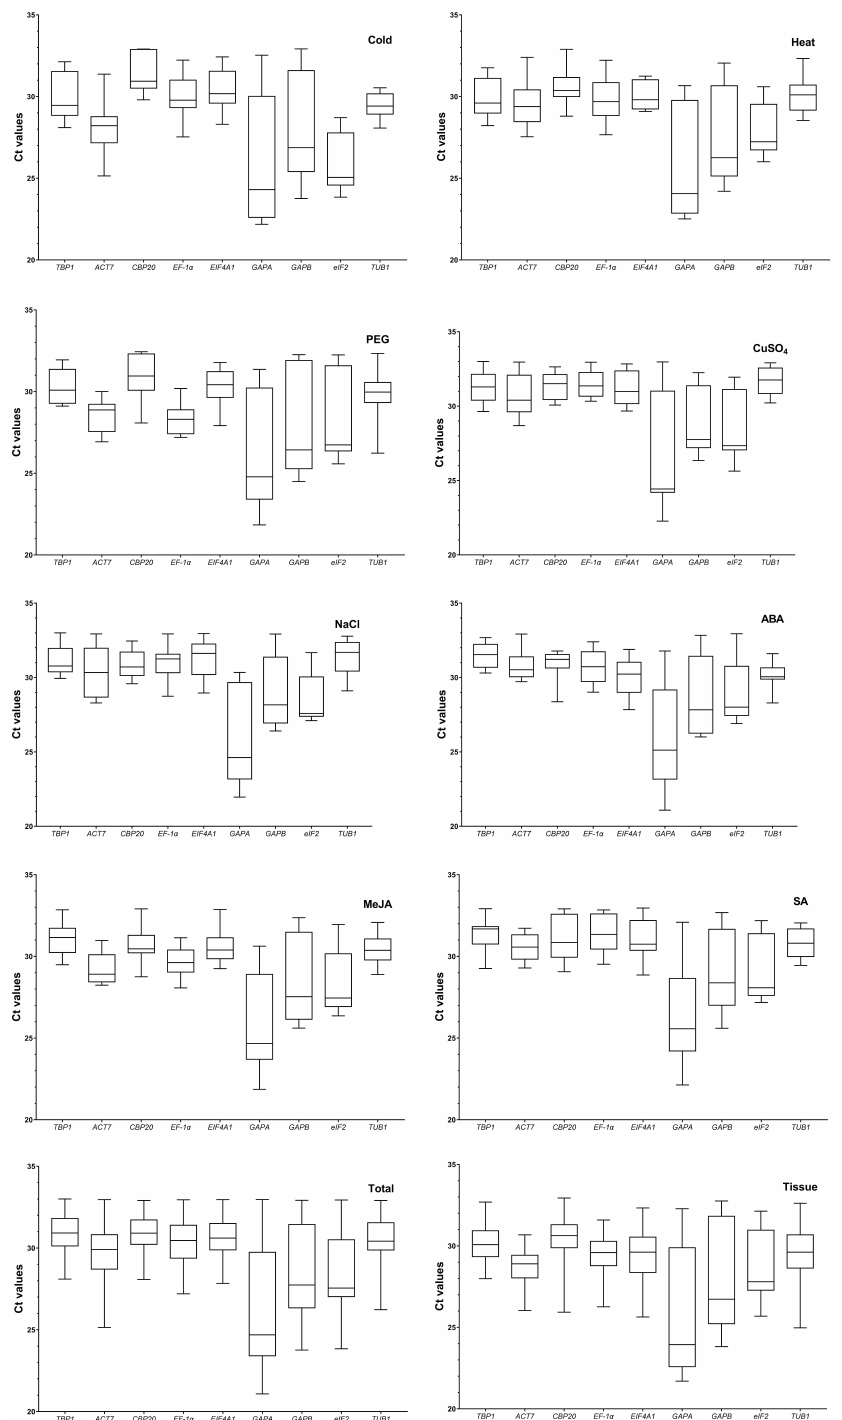
Figure 2. RT-qPCR raw Ct values for nine candidate reference genes in different groups. The box indicates the 25th and 75th percentiles, and whisker caps show the maximum and minimum values. The line across the box depicts the median; the lower the boxes and whisker, the smaller the variations. Cold and Heat represent different temperature shock groups; PEG, CuSO 4 , and NaCl represent drought, heavy-metal, and salinity stress groups, respectively; ABA, MeJA, and SA represent different hormone stimulus groups; Total represents a group of all the samples under experimental conditions; Tissue represents a group of samples including roots, stems and leaves from various control groups and